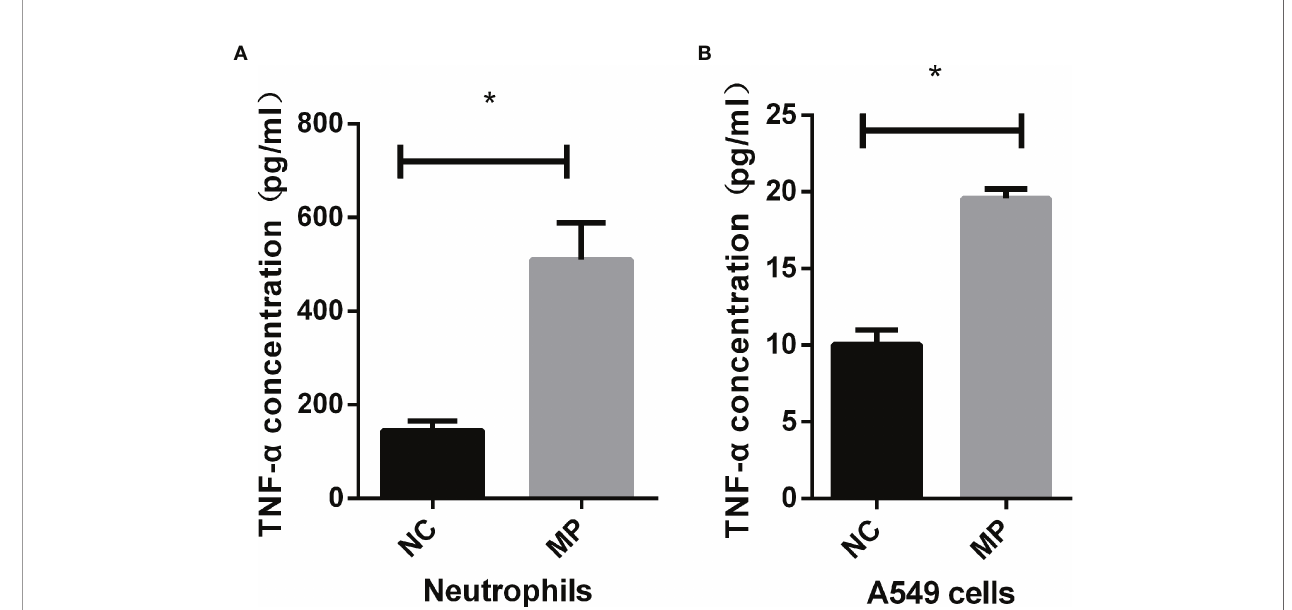
FIGURE 2 | TNF- a secretion by (A) neutrophils and (B) A549 cells upon M. pneumoniae stimulation when compared with the NC group as assessed by ELISA. * P < 0.05 is statistically signi fi cant. NC, normal control; MP, Mycoplasma pneumoniae